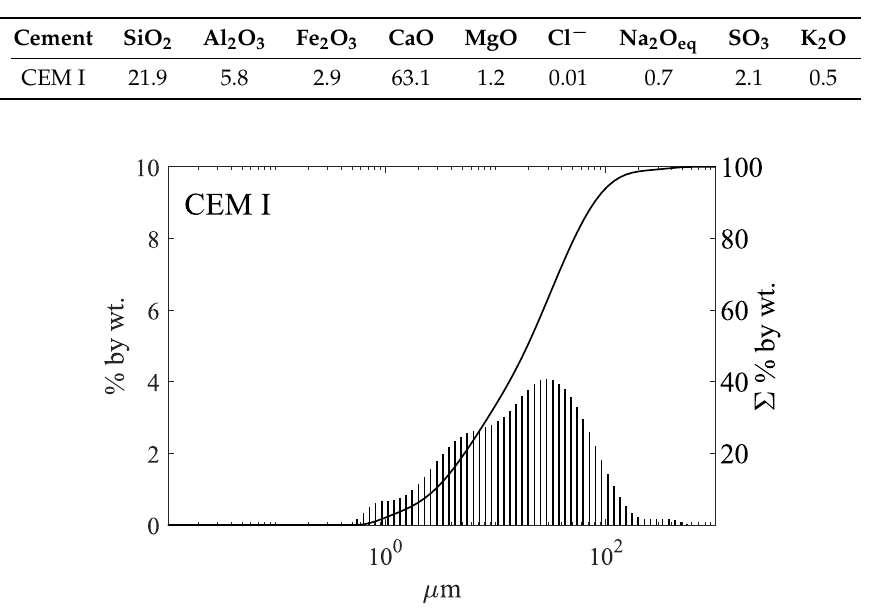
Table 1. Chemical composition of Portland cement CEM I 42.5 R (% mas.).